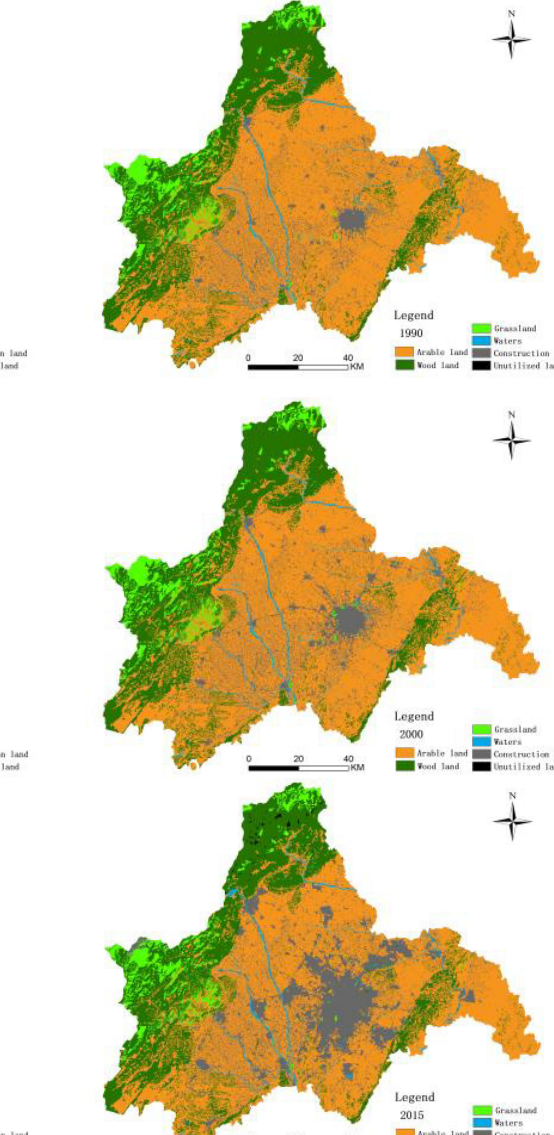
Figure 5. Percentages of land-use types in Chengdu from 1980 to 2015.